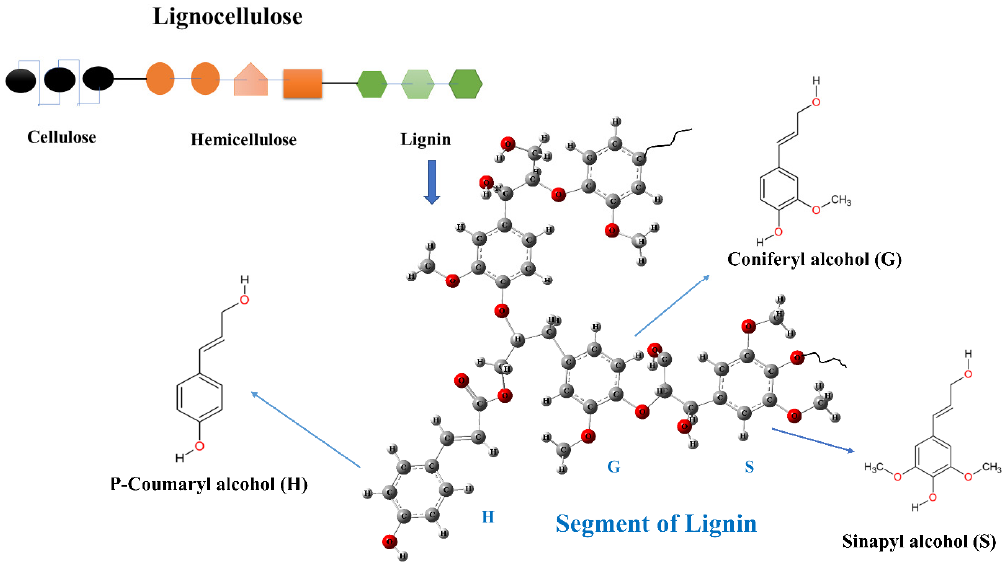
Figure 1. Generalized structure of a segment of lignin.